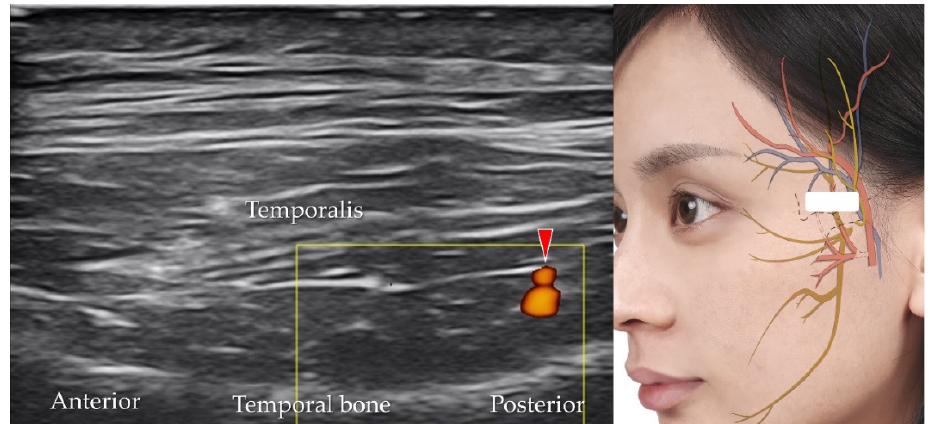
Figure 15. Power Doppler ultrasound imaging of the parietal branch of the deep temporal artery ( red arrowhead ). White square , footprint of the ultrasound transducer.